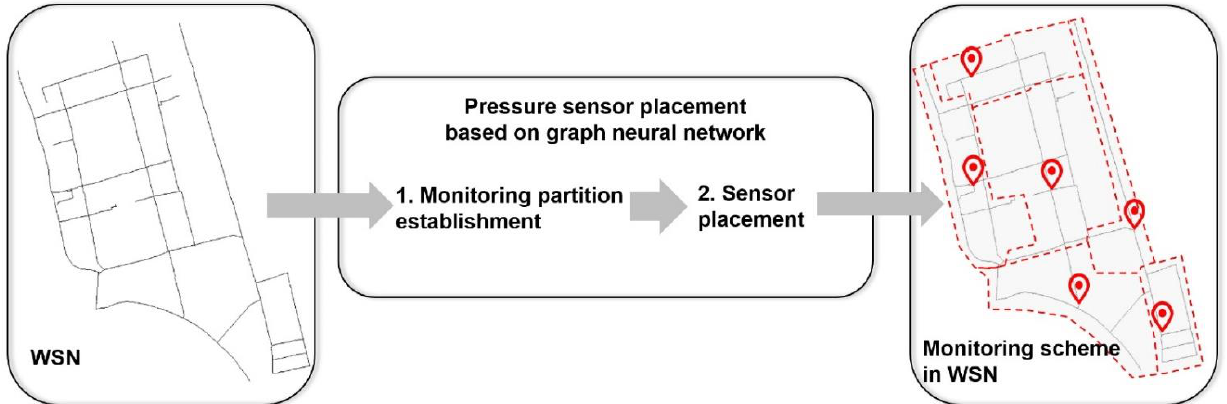
Figure 1. The framework of pressure sensor placement based on graph neural network clustering method.